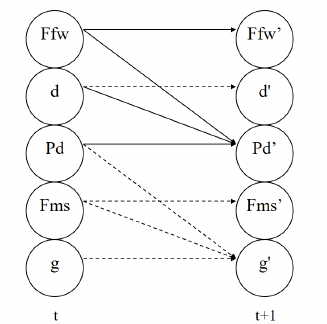
Figure 12. A two-stage Dynamic Bayesian Network for the steam generation system. The solid lines represent the effects for actions a 0 and a 1 and the dashed lines the effects for actions a 2 and a 3